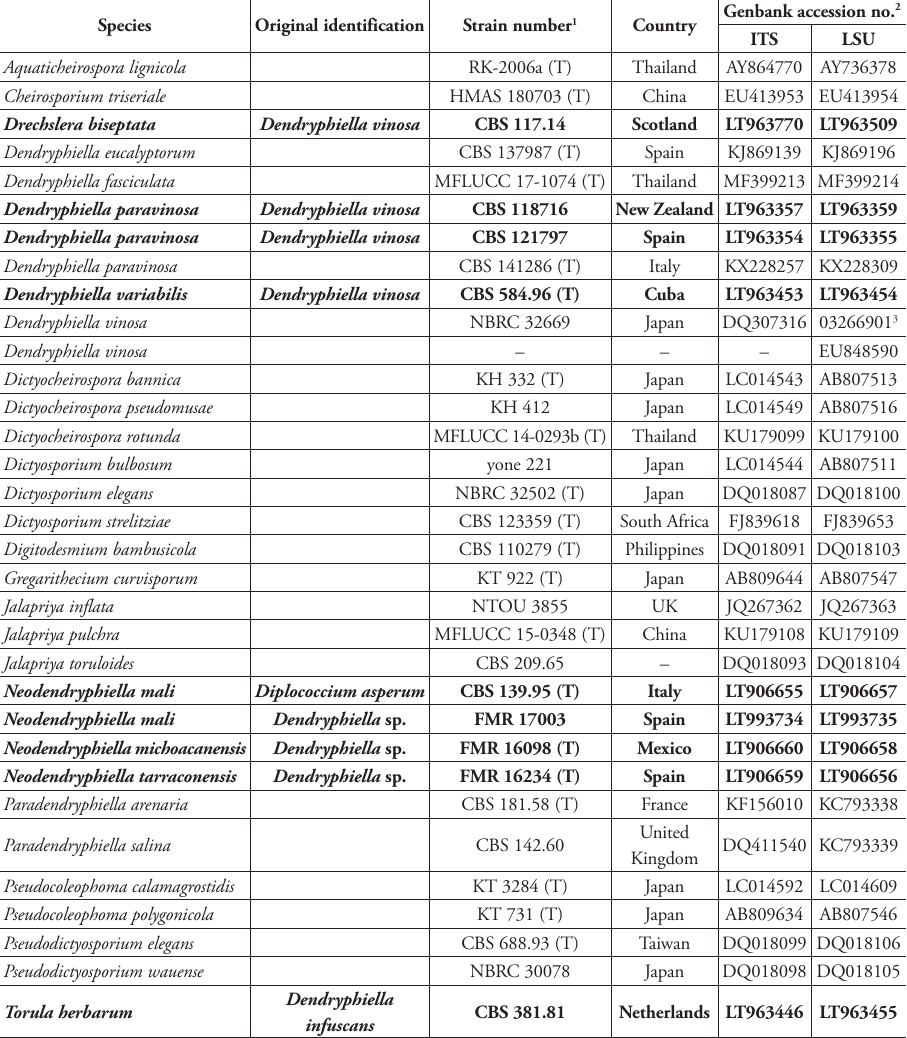
Table 1. Species included in this study, their origin and GenBank accession